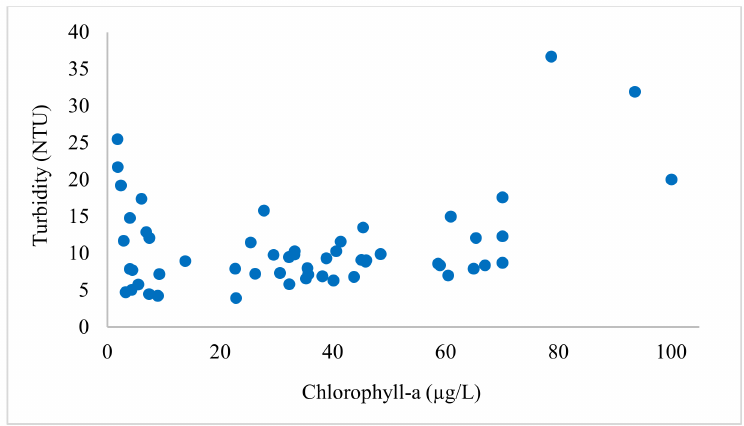
Figure 4. Chlorophyll-a concentration vs. turbidity of samples collected in situ for validation data, in all reservoirs of this study. Determination coefficient for linear relationship (R 2 ) < 0.09. Chl-a and turbidity are practically independent, indicating these reservoirs belong to case 2